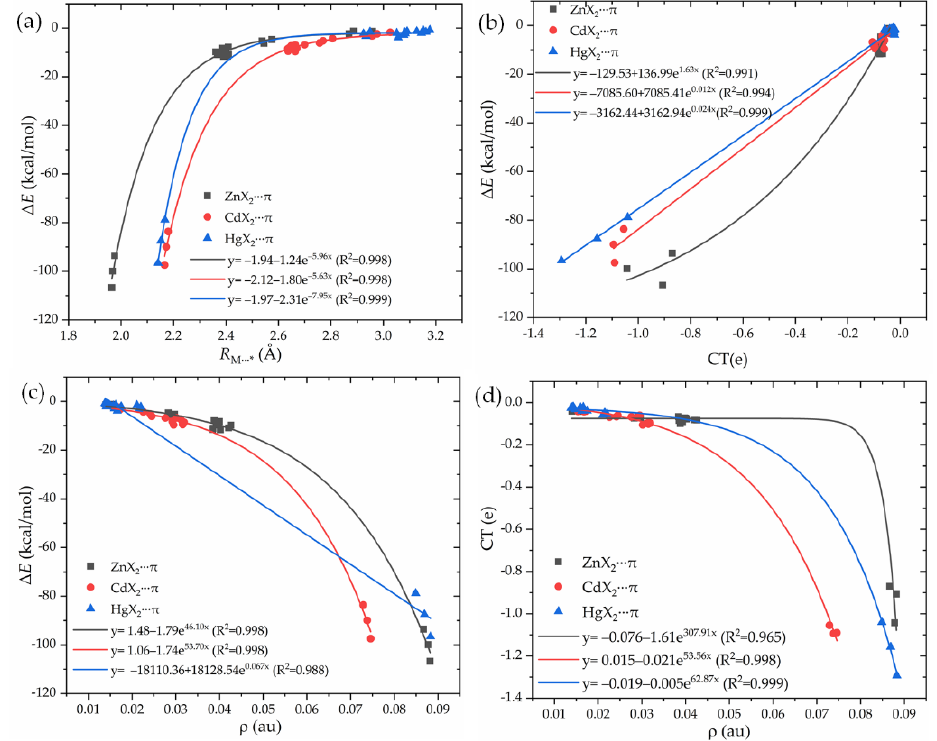
Figure 3. The relationships between the interaction energy Δ E and the binding distance R M··· * ( a ) , charge transfer CT ( b ), or the electron density ρ at the BCP ( c ), and the relationships between CT and ρ at the bond critical point ( d ).